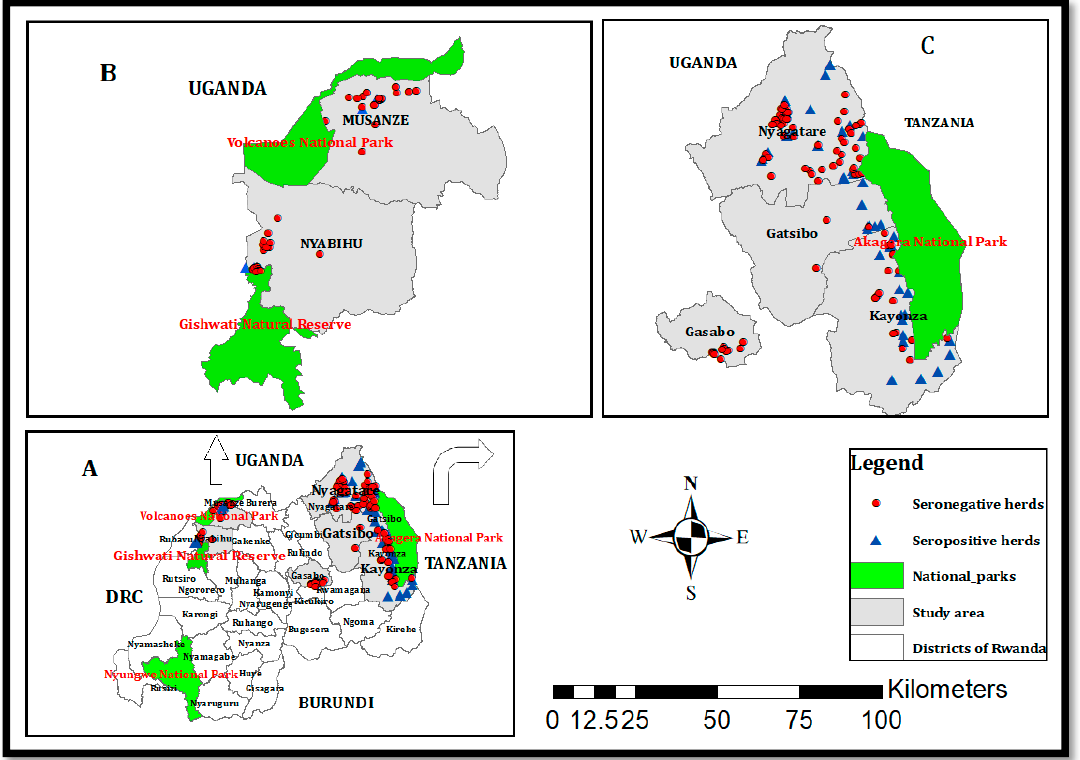
Figure 1. Maps of ( A ) Rwanda with different districts, ( B ) the Musanze and Nyabihu districts border the Virunga and Gishwati national parks, respectively, and ( C ) the Nyagatare, Gatsibo, and Kayonza districts border Akagera National Park, and Gasabo is an urban district with peri-urban areas. Red circles and blue triangles indicate seronegative and seropositive herds found in this study.